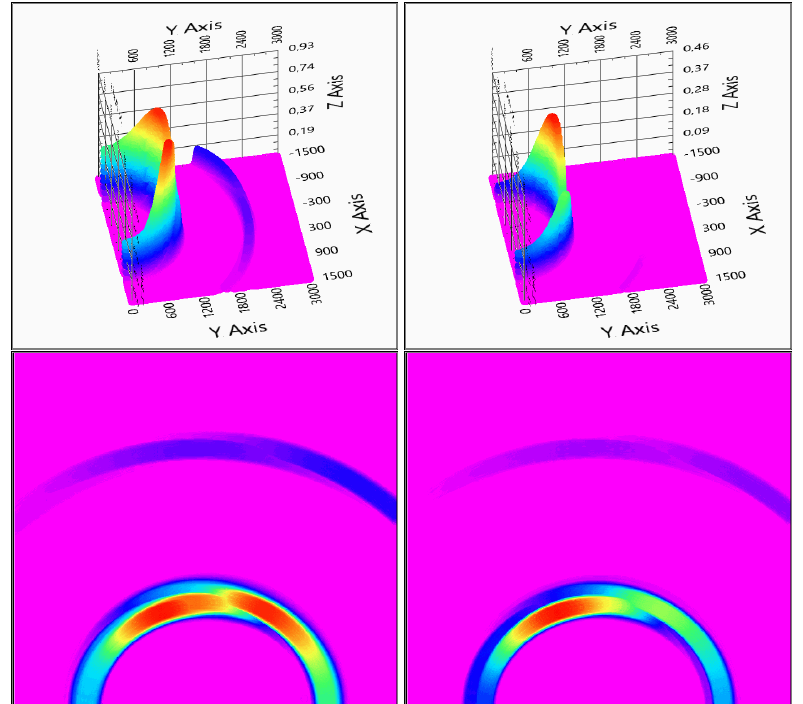
Figure 8. Test measurement with two and three sensors. On the left-hand side, the two sensors measurement on the right-hand side the three sensors measurement is visible. For better visuality in the bottom row, top views are also shown. ( x , y : x , y space axis, z -axis: probability of solid object in an x , y defined position).